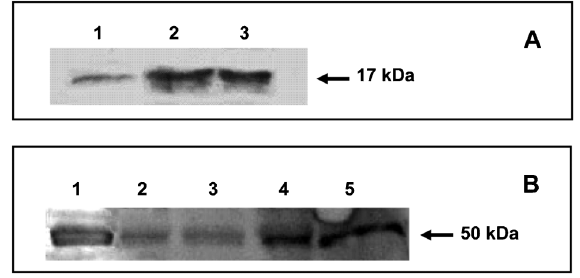
Figure 4. Expression of calmodulin (CaM) and Ca 2 + /calmodulin- dependent protein kinase II (CaMKII) in the membranes of the SERCA-enriched fraction and crude homogenate. A , Immunoblotting with anti-calmodulin antibody. Lane 1 = 24 m g of SERCA-enriched fraction; lane 2 = 32 m g of whole homogenate; lane 3 = 4 m g of chicken cerebellum microsomes (positive control for CaM). B , Immunoblotting with anti-CaMKII antibody. Lanes 1, 2, 3 = 40 m g of 3 different SERCA-enriched fractions from RVD; lane 4 = 4 m g of chicken cerebellum microsomes; lane 5 = 20 m g of innervated fraction of membrane electrocyte of Electrophorus electricus (L.). Lanes 4 and 5 are positive controls for CaMKII. SERCA = sarco(endo)plasmic reticulum Ca 2 + -ATPase.